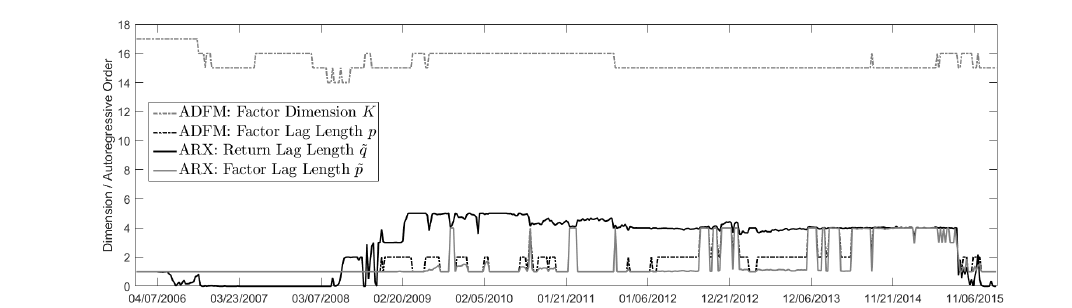
Figure A3. Dimensions and lag orders of factors or returns of the predicted S&P500